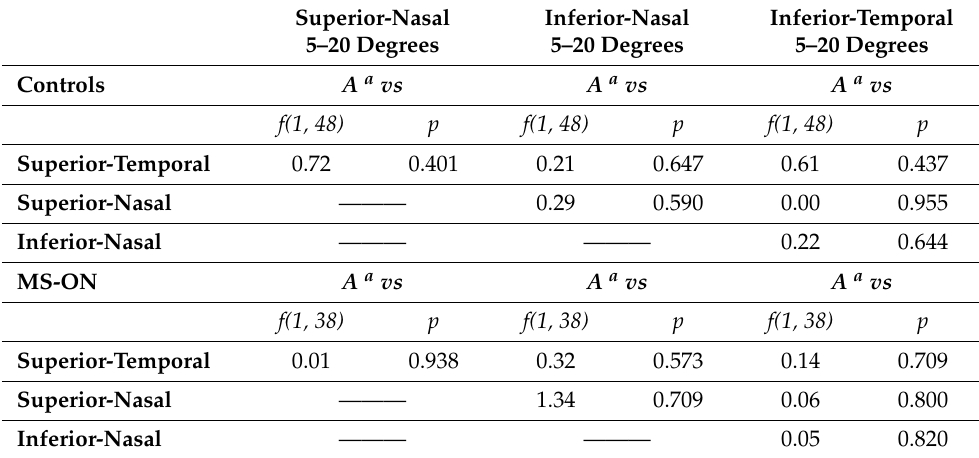
Table 4. Statistical differences between different localized retinal areas of multifocal photopic negative response (mfPhNR) sector analysis data obtained between 5 to 20 degrees in control eyes and in multiple sclerosis patients with optic neuritis (MS-ON). Superior-Nasal 5–20